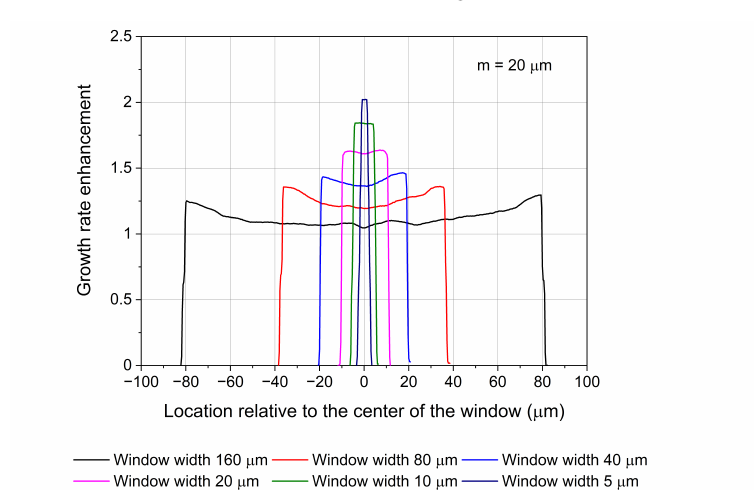
Figure 5. Growth rate enhancement (GRE) as a function of location relative to the window center (layer thickness 500 nm). Variable window width w , constant mask width m = 20 µ